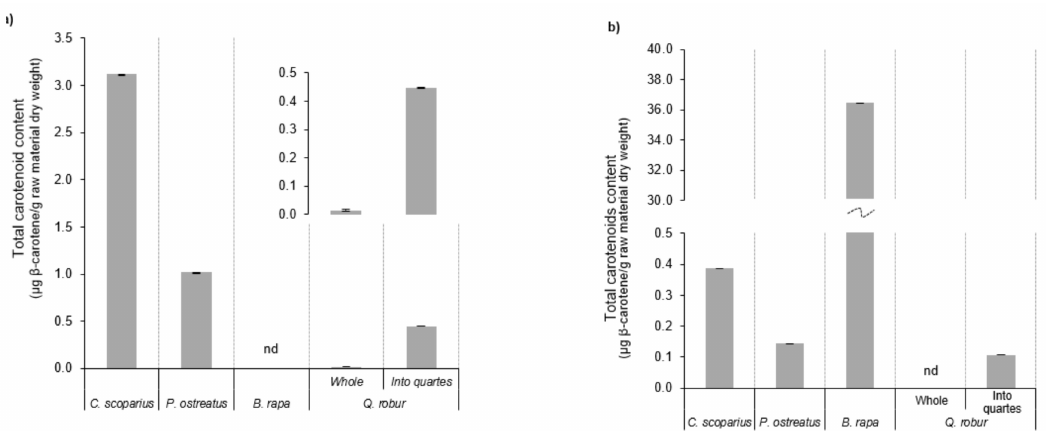
Figure 3. Total carotenoids content from the collected aqueous extracts of the di ff erent took in consideration raw materials at 100 W by MHG extraction ( a ) and ethanol extracts collected by SLE ( b ) of the evaluated feedstocks. nd: no